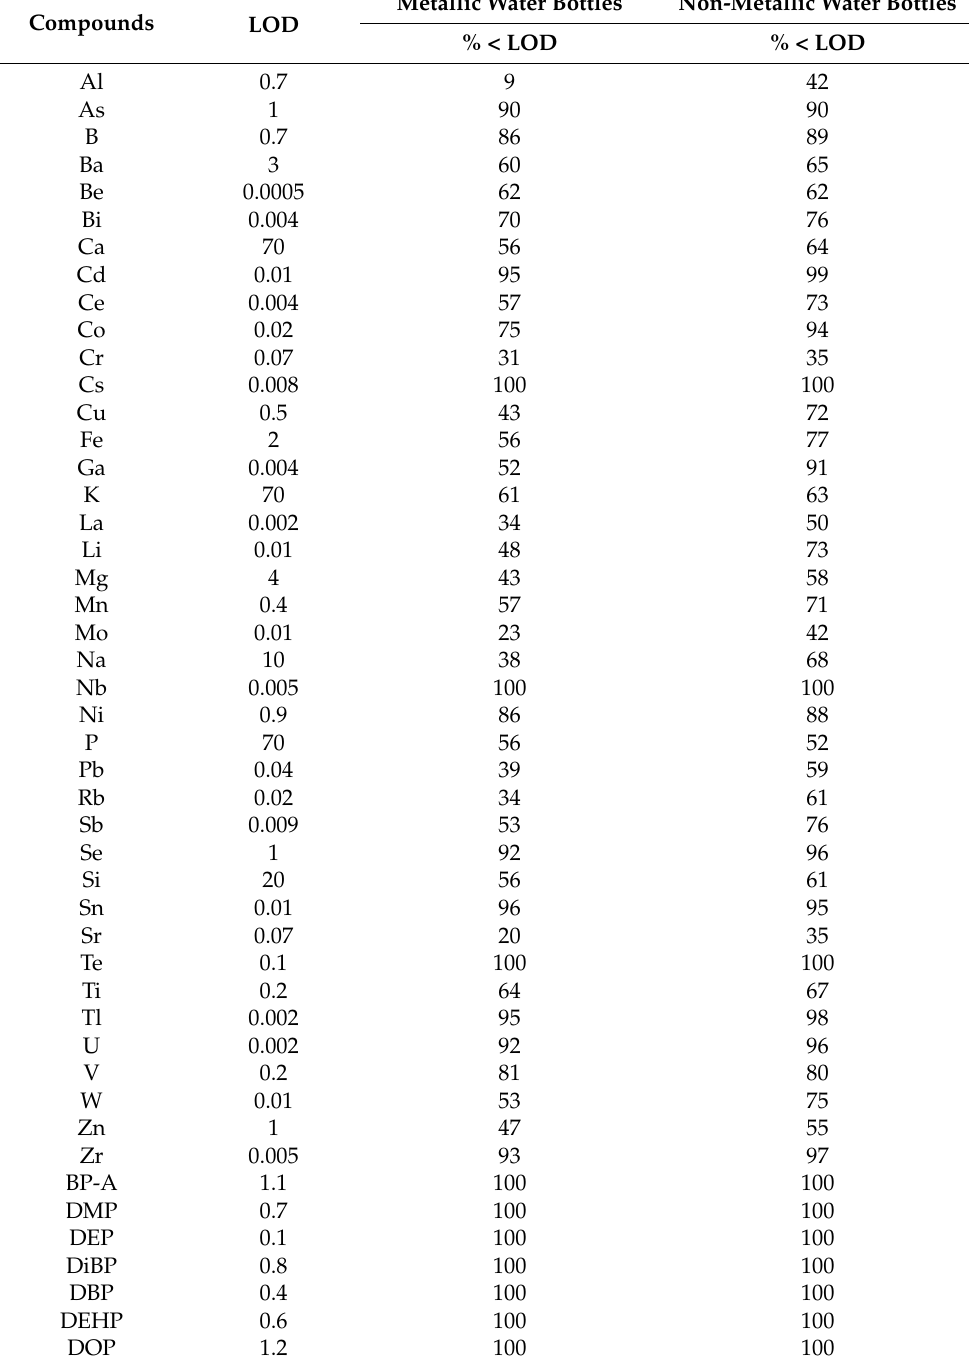
Table 3. Limits of detection (LODs) ( µ g L − 1 ) of studied compounds in water samples stored in metallic (stainless steel and aluminum) and non-metallic bottles and % of bottles in which the specific analyte was <